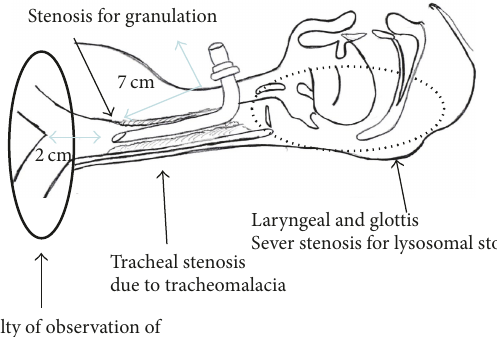
Figure 2: Image of the patient’s airway. His larynx was extremely stenotic due to lysosomal storage disease. His trachea was stenosed by granulation tissue secondary to a previous tracheostomy and tracheomalacia. Therefore, peripheral observation was